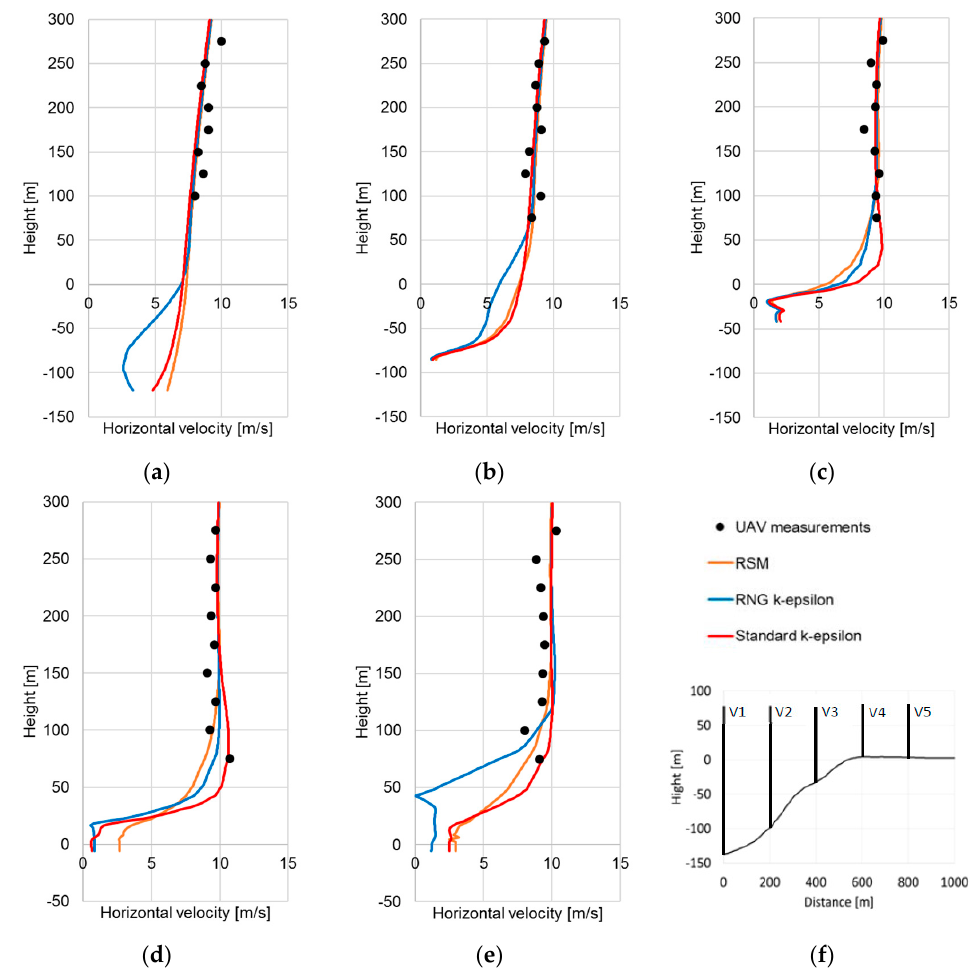
Figure 10. ( a ) Horizontal velocity profile at position V1; ( b ) horizontal velocity profile at position V2; ( c ) horizontal velocity profile at position V3; ( d ) horizontal velocity profile at position V4; ( e ) horizontal velocity profile at position V5; ( f ) legend and positions of vertical evaluation lines.